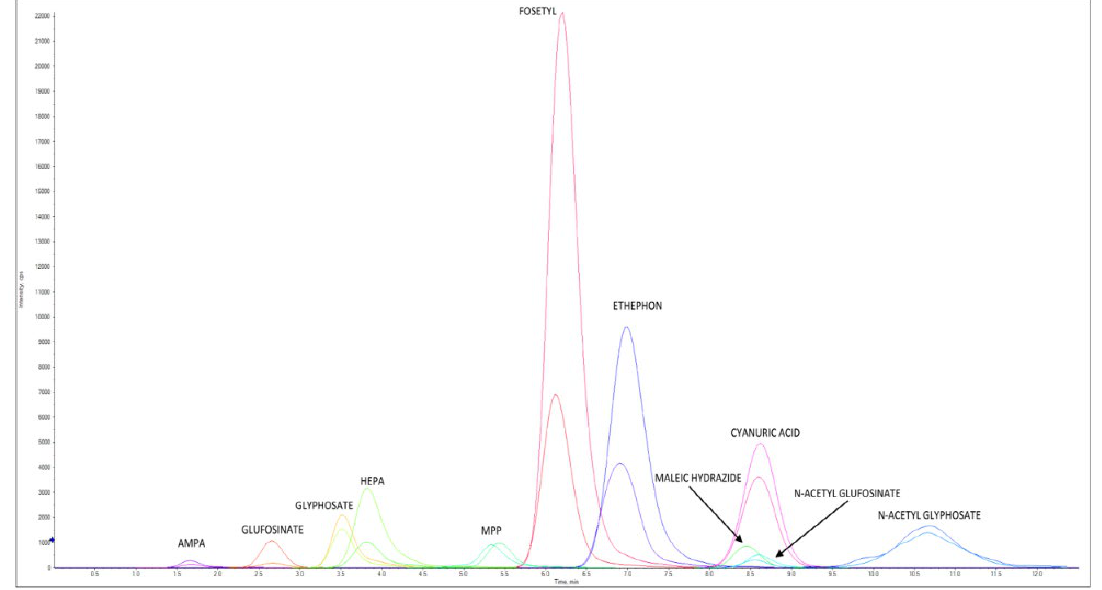
Figure 4. LC–MS/HRMS chromatogram of cow milk extract spiked at 0.040 mg/kg for AMPA, cyanuric acid, ethephon, fosetyl Al, glyphosate, HEPA, maleic hydrazide, and N-Acetyl-glyphosate and at 0.008 mg/kg for glufosinate ammonium, MPP, and NAG. Concentration levels for ILIS were 0.006 mg/kg for AMPA- 13 C, 15 N, cyanuric acid 3 C 3 , ethephon D 4 , fosetyl Al D 15 , glyphosate 2- 13 C, 15 N, HEPA D 4 , and N-Acetyl-glyphosate 13 C 2 , 15 N and at 0.0012 mg/kg for glufosinate ammo- nium D 3 , MPP D 3 , and NAG D 3 . For each native pesticide and relative ILIS, one ion is